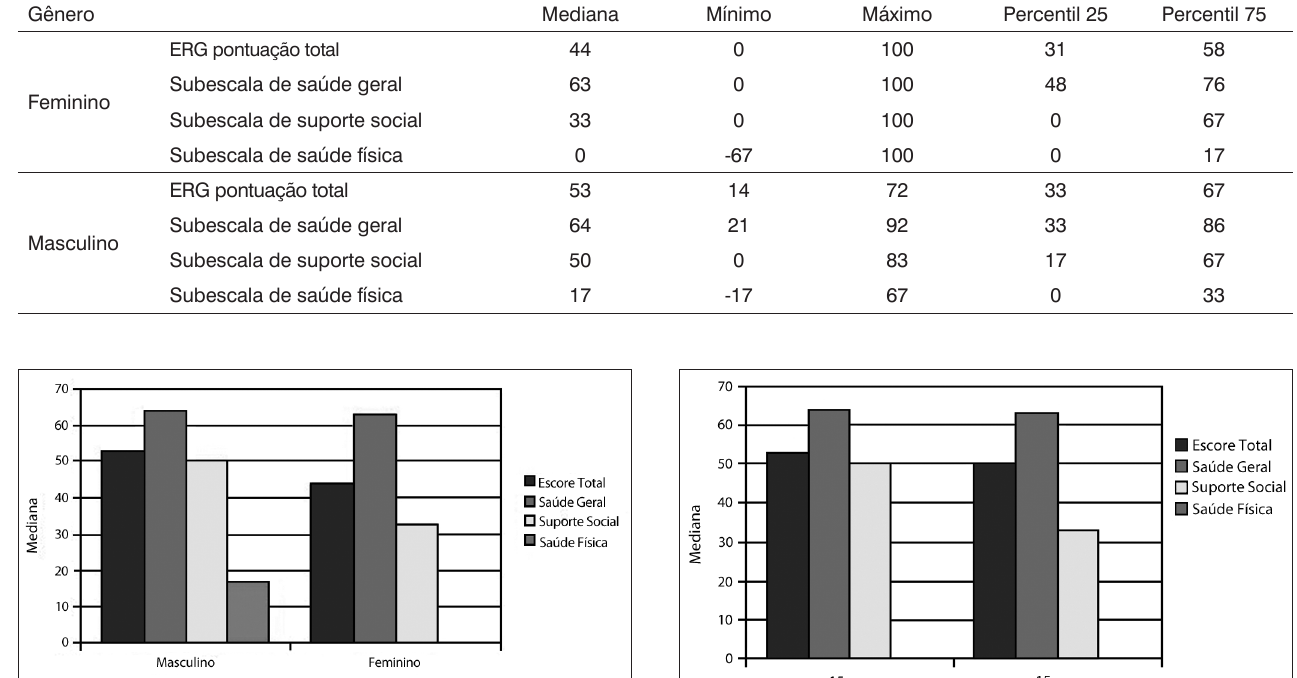
Tabela 1. Valores de mediana conforme o sexo.